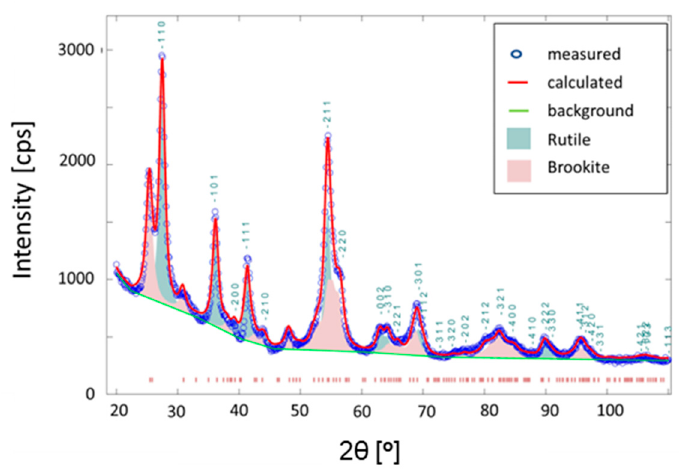
Figure 6. XRD pattern of annealed nanoparticle film (blue circles) and the fit of the experimentally obtained pattern (red line). In the case of crystallographic peaks of rutile, individual crystallographic planes are indicated. In contrast, due to the numerous peaks that correspond to brookite, only the positions of the individual peaks are indicated by red lines at the bottom of the figure for better clarity. The deposition time was 3 min, the annealing temperature 450 °C, and the annealing time 120 min.